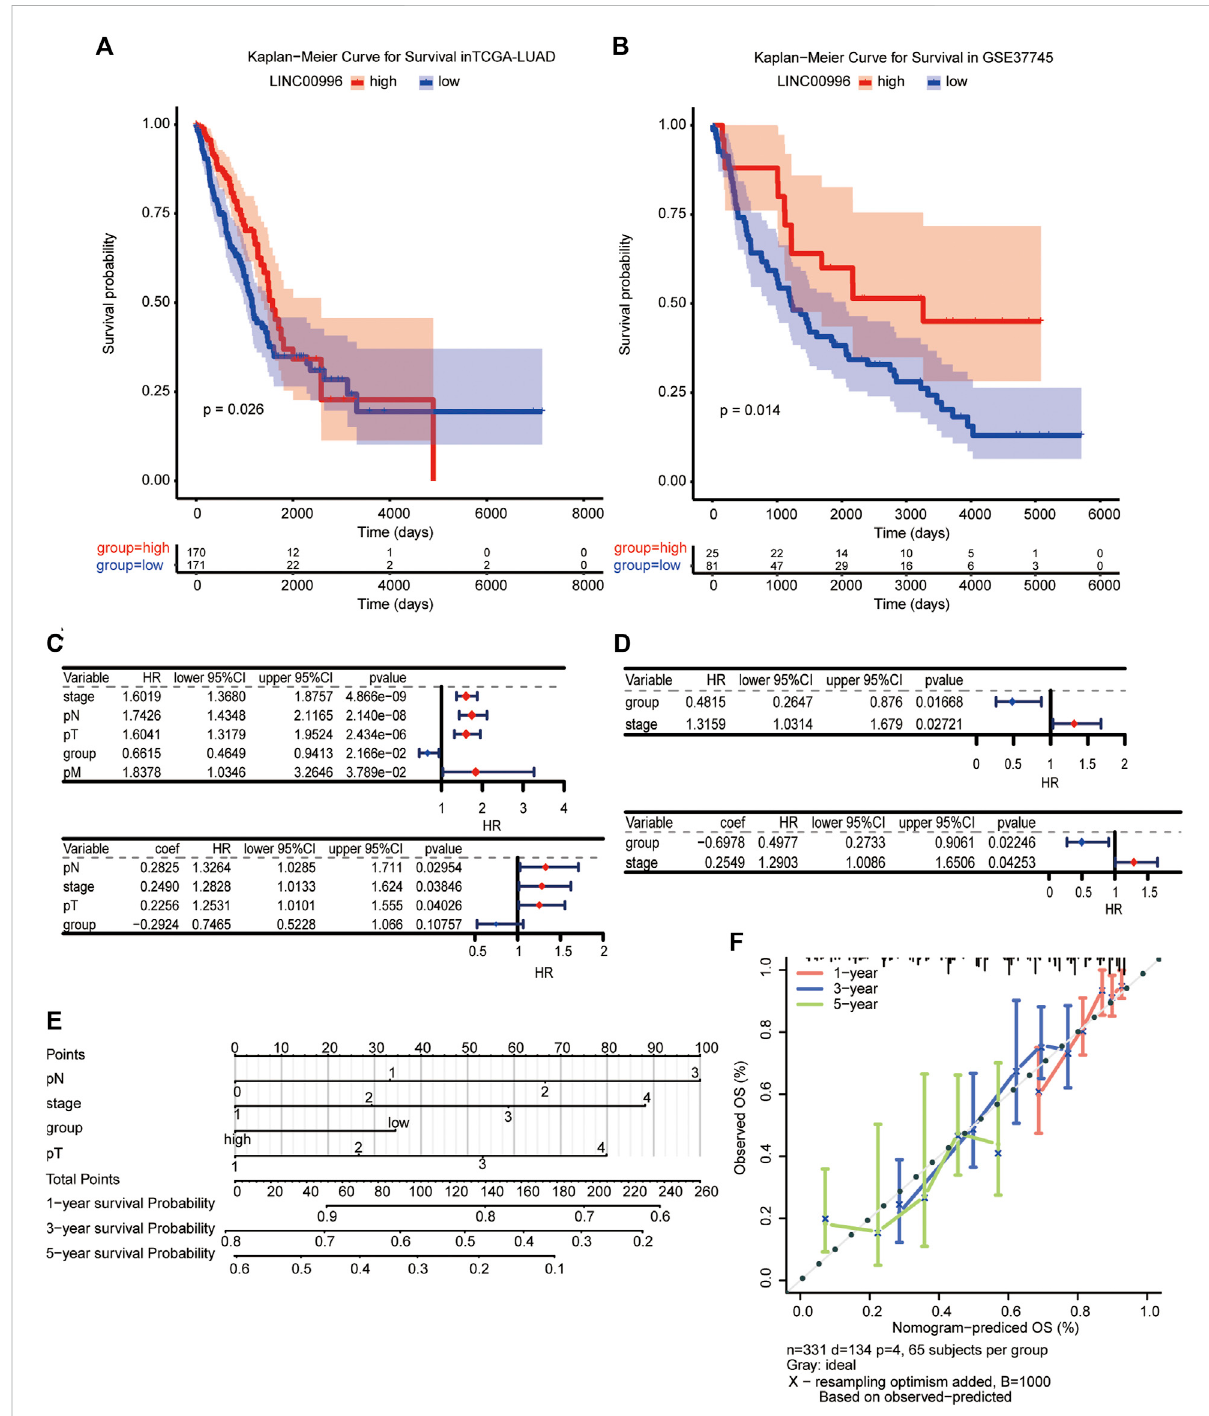
FIGURE 2 (A,B) Kaplan – Meier survival analysis of TCGA-LUAD and GSE37745, with signi fi cant differences among different groups, p < 0.05. (C,D) Independent prognosis forest plot of LUAD patients (TCGA-LUAD univariate and TCGA-LUAD multivariate; GSE37745 univariate and GSE37745 multivariate, respectively). (E, F) A visualization model of the nomogram and an overall calibration